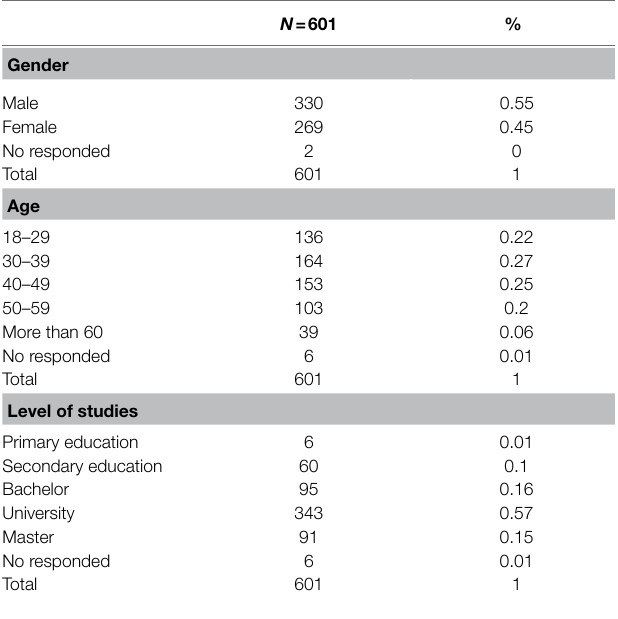
TABLE 2 | Sample composition.